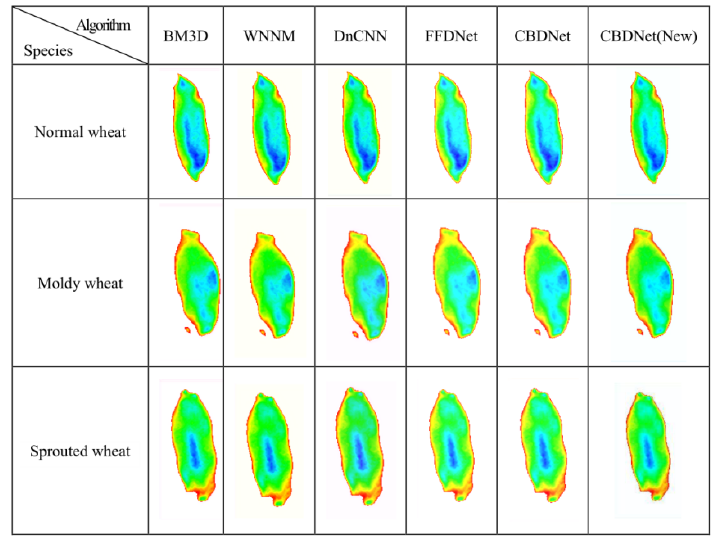
Figure 7. The comparison of the results of each denoising network. Table 1. A comparison of PSNR/SSIM results based on denoising networks. Images